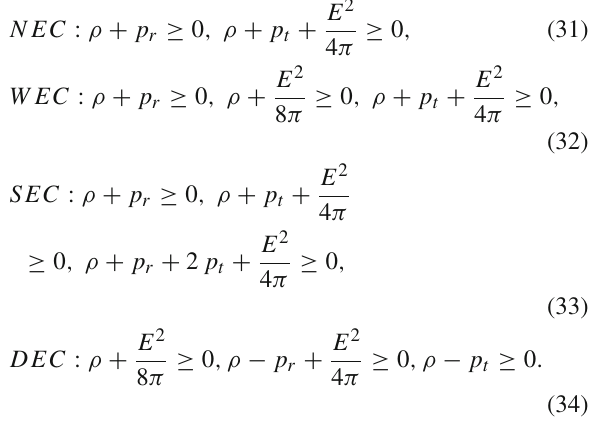
anisotropic charged stellar system have to be consistent with all the inequalities simultaneously as